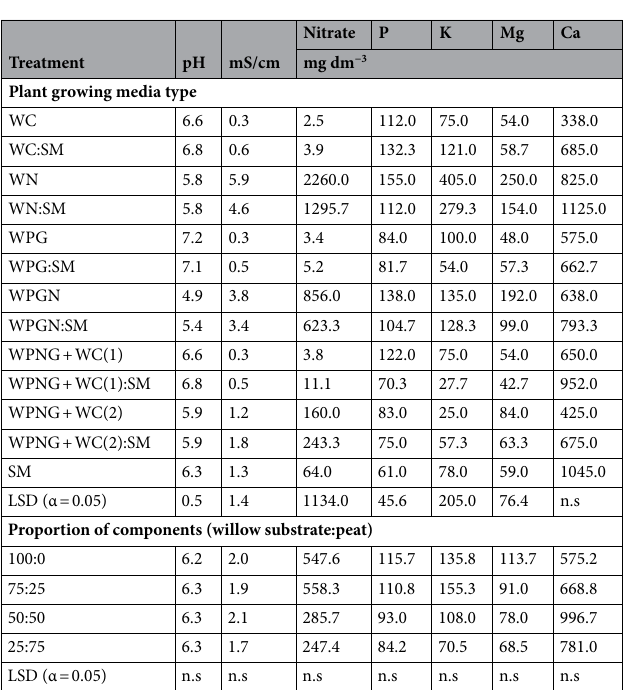
Table 7. Horticulture media chemical